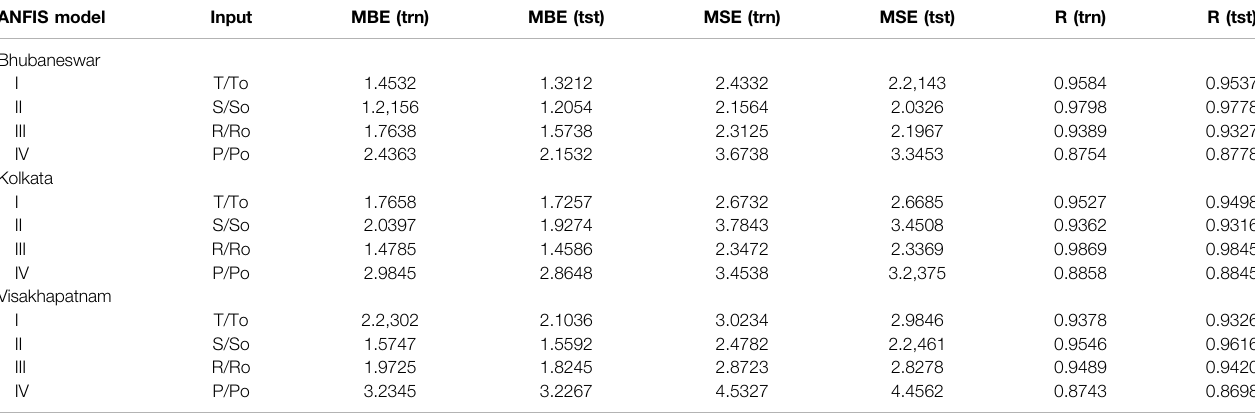
TABLE 4 | ANFIS models for Bhubaneswar, Kolkata, and Visakhapatnam (single input). ANFIS